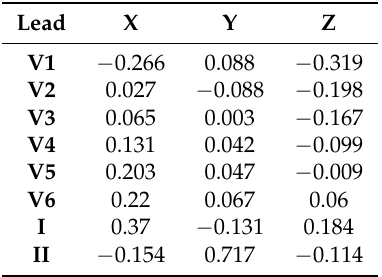
Table 4. Coefficients for the QRS complex (QLSV)